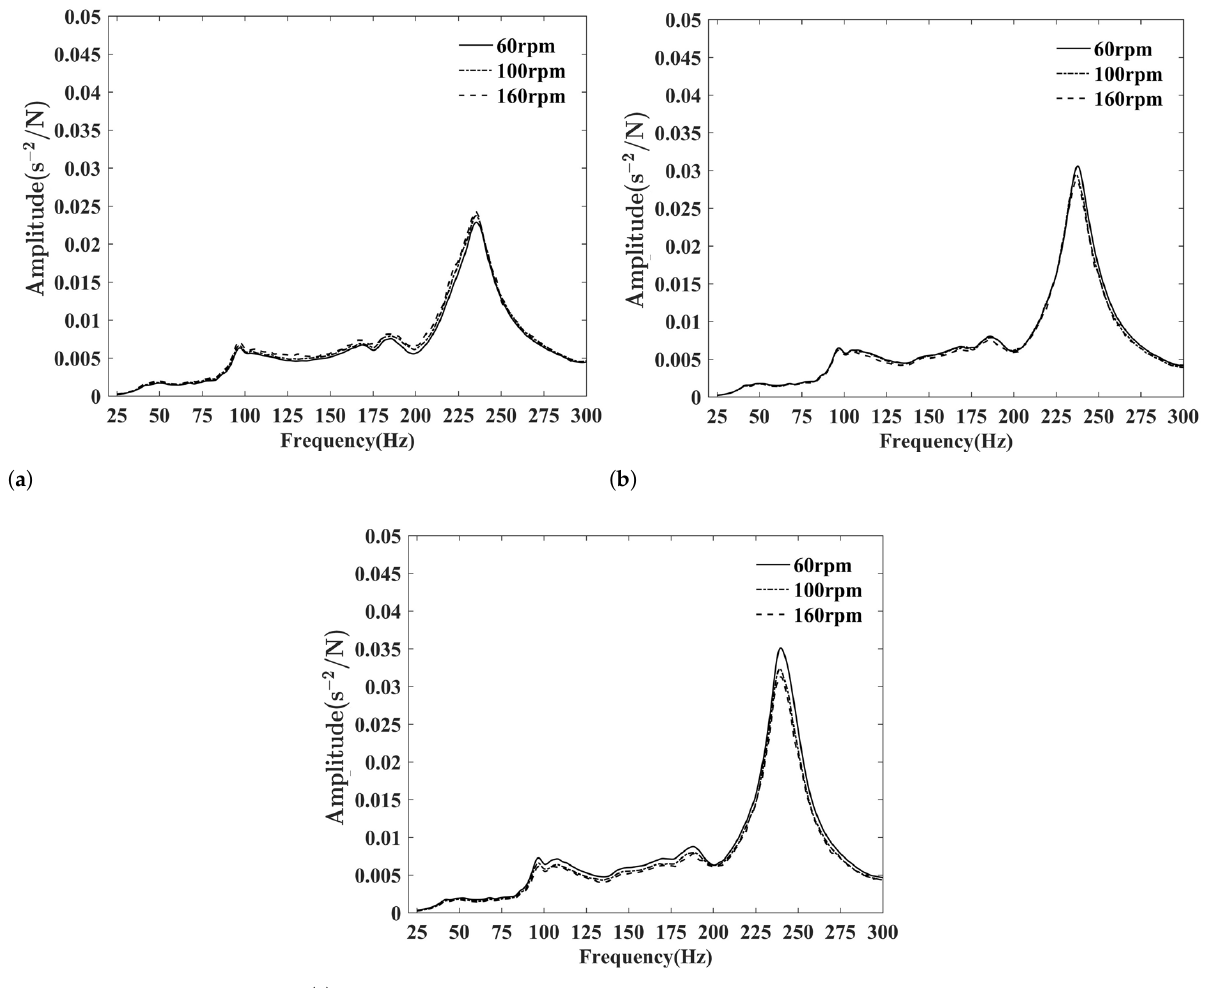
Figure 3. Responses of different rotational speeds while: ( a ) under static thrust 10 kN; ( b ) under static thrust 30 kN; ( c ) under static thrust 50